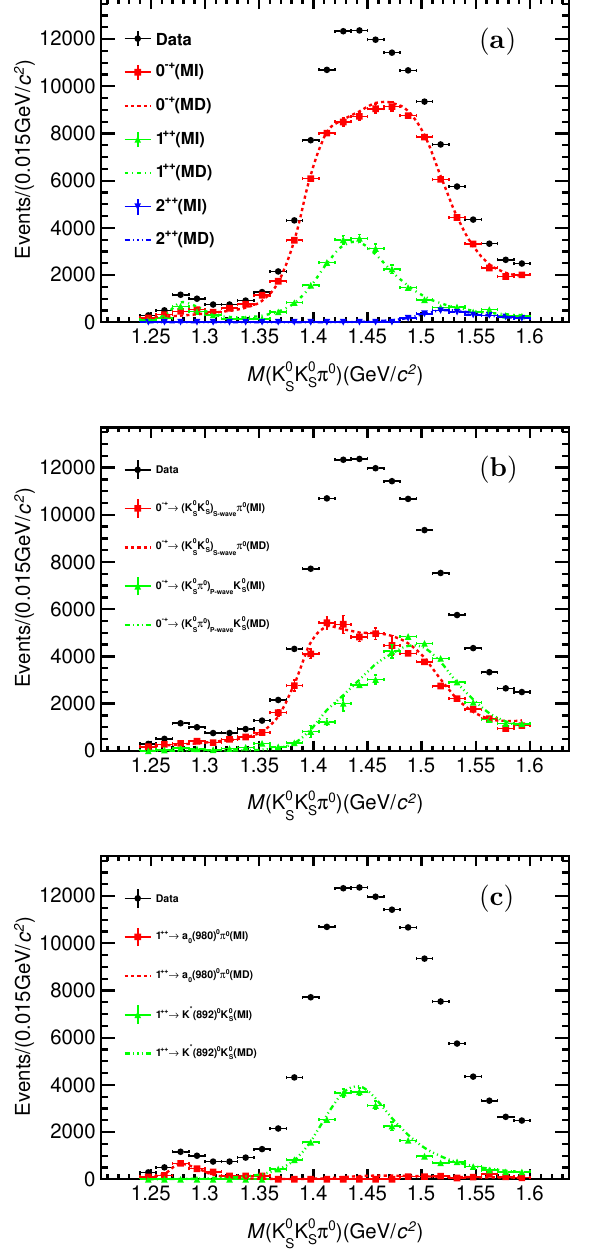
Figure 6 . The K 0 K 0 π 0 intensity spectra for the (a) dominant spin-parity components, (b) dom- S S inant decay modes for the pseudoscalar component, and (c) dominant decay modes for the axial vector component. The dots with error bars and the dotted lines are the intensity obtained from the MI PWA and MD PWA results, respectively. The uncertainty on the total data is statistical, and those of the others are obtained from the PWA in each